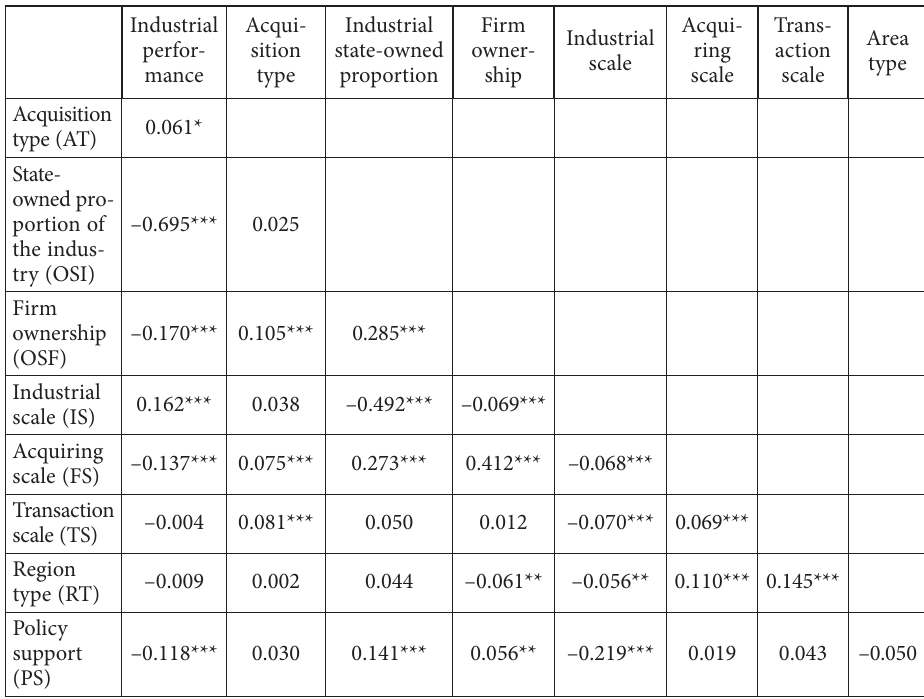
Table 3. Pearson correlation coefficient